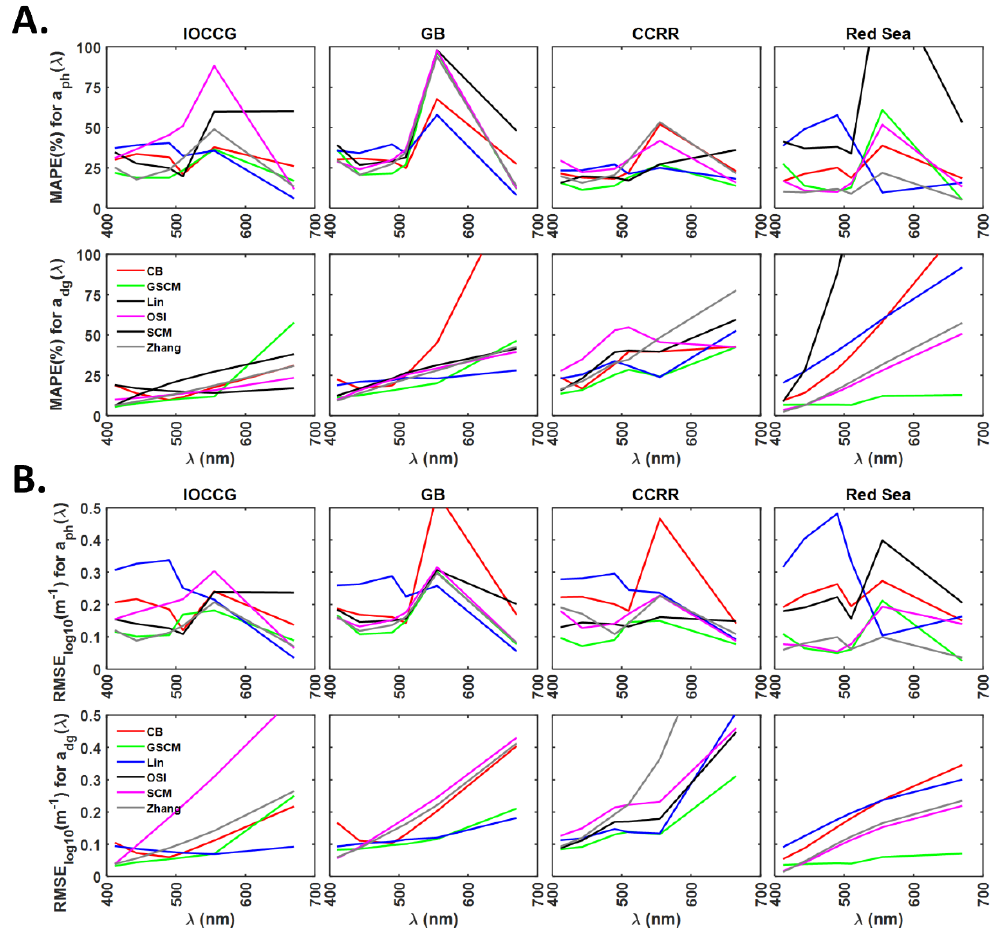
Figure 5. Comparison of the six ADAs, CB, GSCM, Lin’s, OSI, SCM and Zhang’s, in deriving a ph ( λ ) and a dg ( λ ) from a nw ( λ ) using statistical indicators ( A ). MAPE, ( B ). RMSE in log scale.